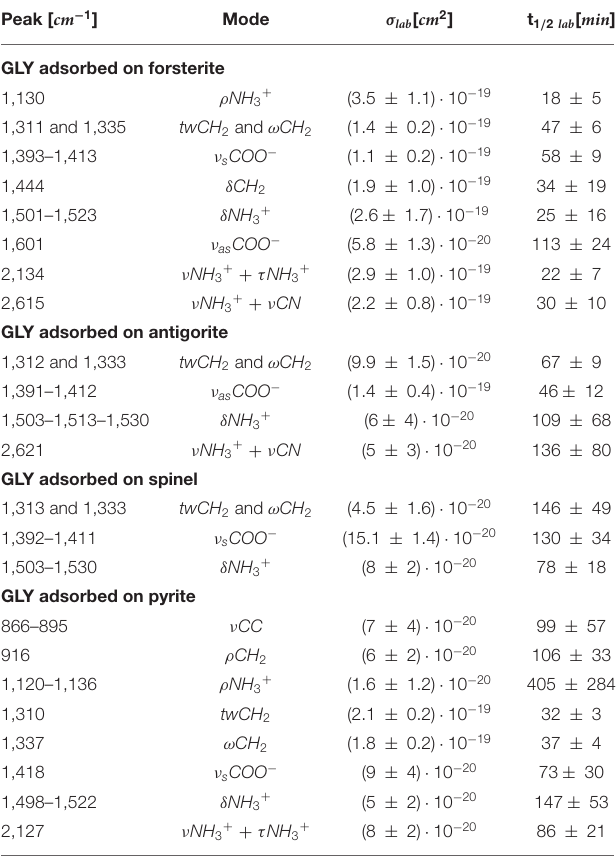
TABLE 6 | Destruction cross sections σ lab and half-life t 1 / 2 lab in laboratory conditions for single bands of GLY adsorbed on minerals under UV irradiation. Peak [ cm − 1 ] Mode σ lab [ cm 2 ] t 1 / 2 lab [ min